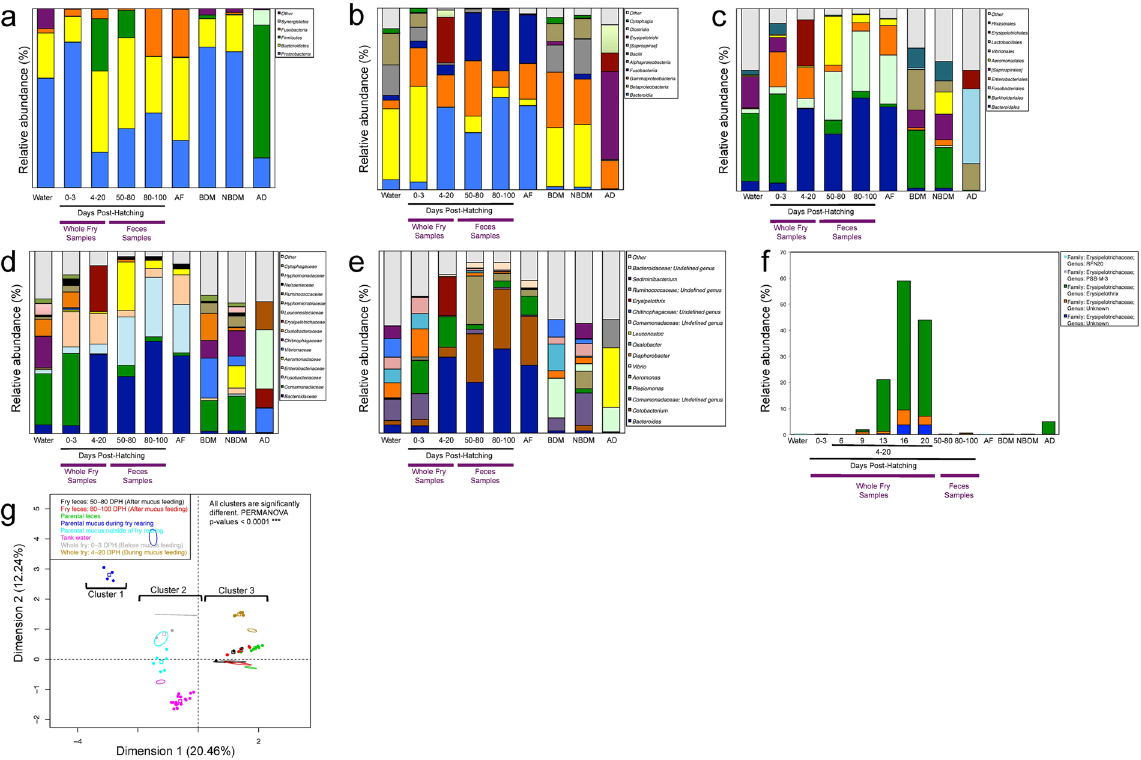
Figure 2. Convergence of whole larvae and fry feces microbial community towards adult-like gut microbiota. The bar charts in ( a , b , c , d and e ) respectively represent the relative abundances (%) of the most abundant 5 bacterial phyla, 10 bacterial classes, 10 bacterial orders, 15 bacterial families, and 15 bacterial genera in all samples, in regards to the number of DPH. In this figure, “AF” stands for “Adult feces” (or feces from the discus parents), “BDM” stands for “Breeding discus mucus”, “NBDM” stands for “Non-breeding discus mucus”, and “AD” stands for “Adult diet”. In ( f ), the relative abundances (%) of five OTUs from the Erysipelotrichaceae family is shown in regards to the number of DPH and to the different microbial niches studied. Note that in ( f ), the developmental stage from 4–20 DPH is decomposed in its five samplings at 6, 9, 13, 16, and 20 DPH to document more precisely the increased abundance of the Erysipelotrichaceae family during this key developmental stage. In ( g ), a Multi-Factorial Analysis (MFA) is shown including all the samples from the different niches (except the sample from Adult diet, since it distorted the representation of all the other samples). The MFA was constructed with the FactomineR package from R, using the relative abundance of the 50 most abundant OTUs in all samples. Confidence ellipses highlight differences at a 0.95 confidence threshold. PERMANOVAs between the three clusters were done on a Thetayc distance matrix, using the vegan package from R, with 10 000 permutations.